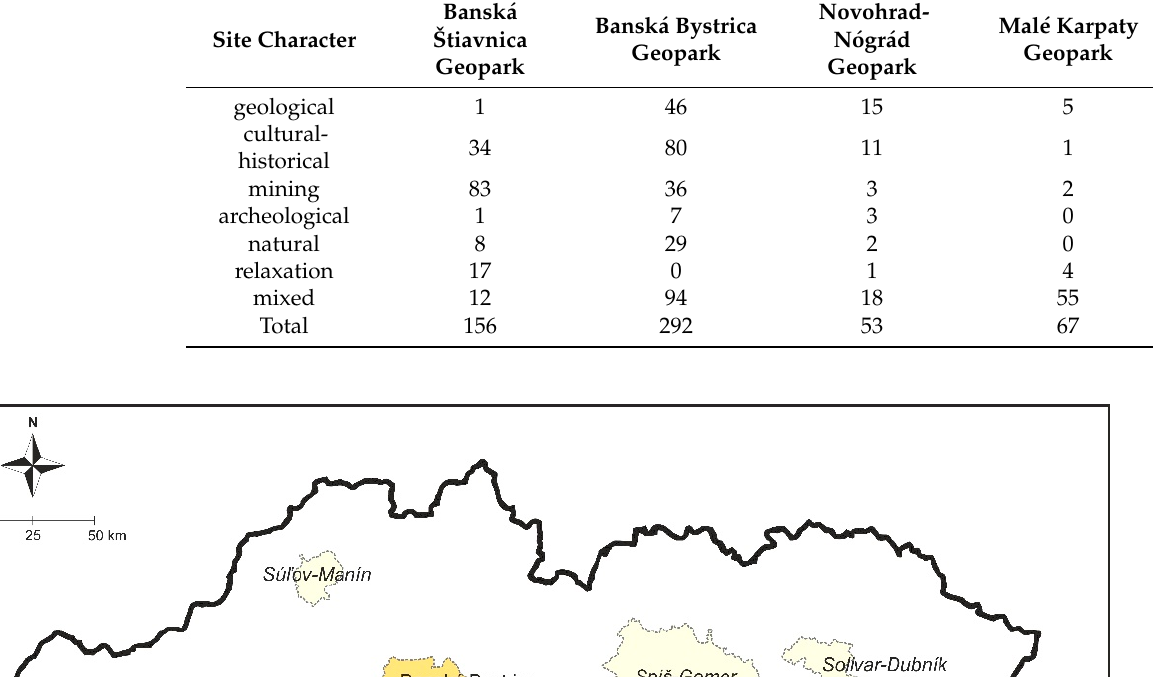
Table 2. Types and numbers of sites in Slovak geoparks as identified by geopark operators [45].